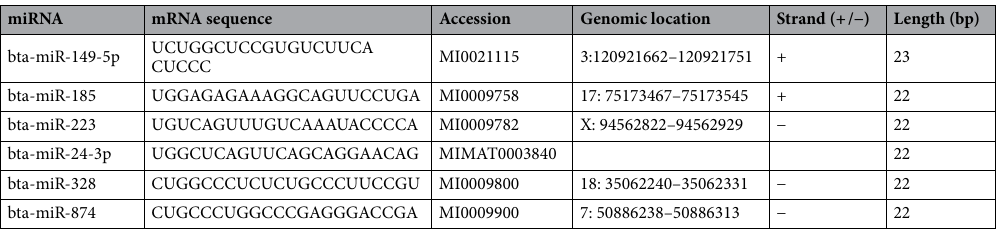
Table 2. Significant miRNA predicted by all three software and their mRNA sequence, accession number, genomic location, strand type and length. These miRNAs are from the Venn diagram generated through the overlap of the three softwares-miRWalk, miRNet an TargetScan.